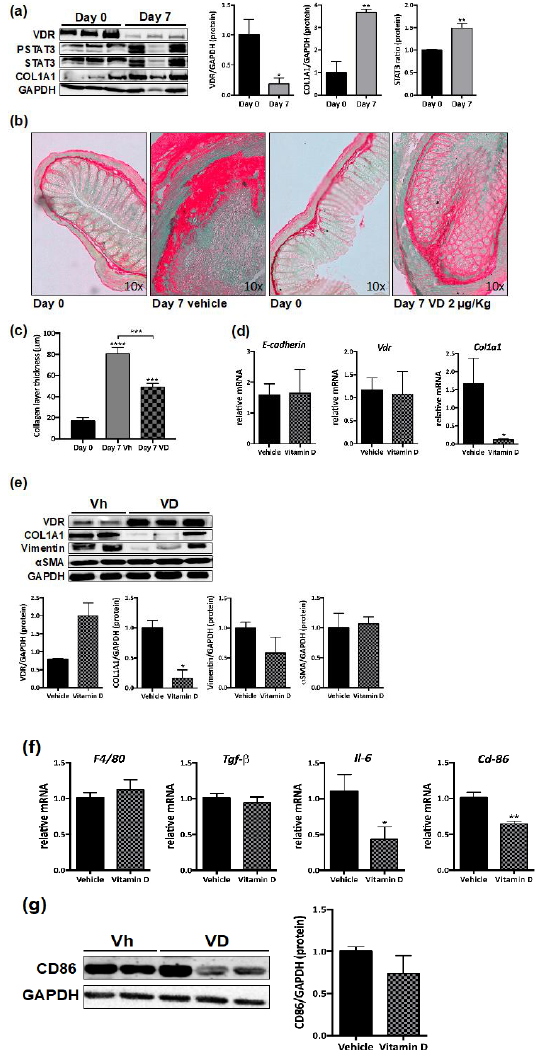
1 Figure 4. VD reduces murine intestinal fibrosis. ( a ) Western blots of protein levels in total lysates from intestinal grafts at day 0 (control) ( n = 3) or seven days after transplantation ( n = 3). Graphs show protein expression vs. GAPDH represented as fold induction vs. day 0. Bars in graph represent mean ± s.e.m., and significant di ff erences vs. day 0 are shown by * p < 0.05 or ** p < 0.01 ( b ) Sirius Red staining was performed in para ffi n-embedded intestinal tissue at day 0 and in intestinal explants. Representative pictures taken under transmission light. ( c ) Graph shows the collagen layer thickness quantified in intestine and grafts by Image J. Significant di ff erences vs. day 0 or vs. 7 days-vehicle (connecting lines) are shown by *** p < 0.001. ( d ) Graphs show the relative mRNA expression (expressed as fold induction vs. vehicle-treated group) of di ff erent genes vs. β -actin in intestinal explants from mice treated for 7 days with VD 2 µ g / kg ( n = 6) or vehicle ( n = 6). ( e ) Western blot images of protein expression from 7 day grafts from mice treated with VD ( n = 3) or vehicle ( n = 2). Graphs represent protein expression vs. GAPDH quantification expressed as fold induction vs. vehicle-treated group. In ( d ) and ( e ) , bars in graph represent mean ± s.e.m. and significant di ff erences vs. the vehicle group are shown by * p < 0.05. ( f ) Graphs show the mRNA expression of di ff erent genes vs. β -Actin (expressed as fold induction vs. vehicle) in 7 day grafts from mice treated with VD ( n = 6) or vehicle ( n = 6). Bars in graph represent mean ± s.e.m., and significant di ff erences vs. the vehicle group are shown by * p < 0.05 or ** p < 0.01. ( g ) A Western blot showing CD86 protein levels in grafts from vh- or VD-treated mice. The graph represents protein expression vs. GAPDH quantification expressed as fold induction vs. vehicle-treated